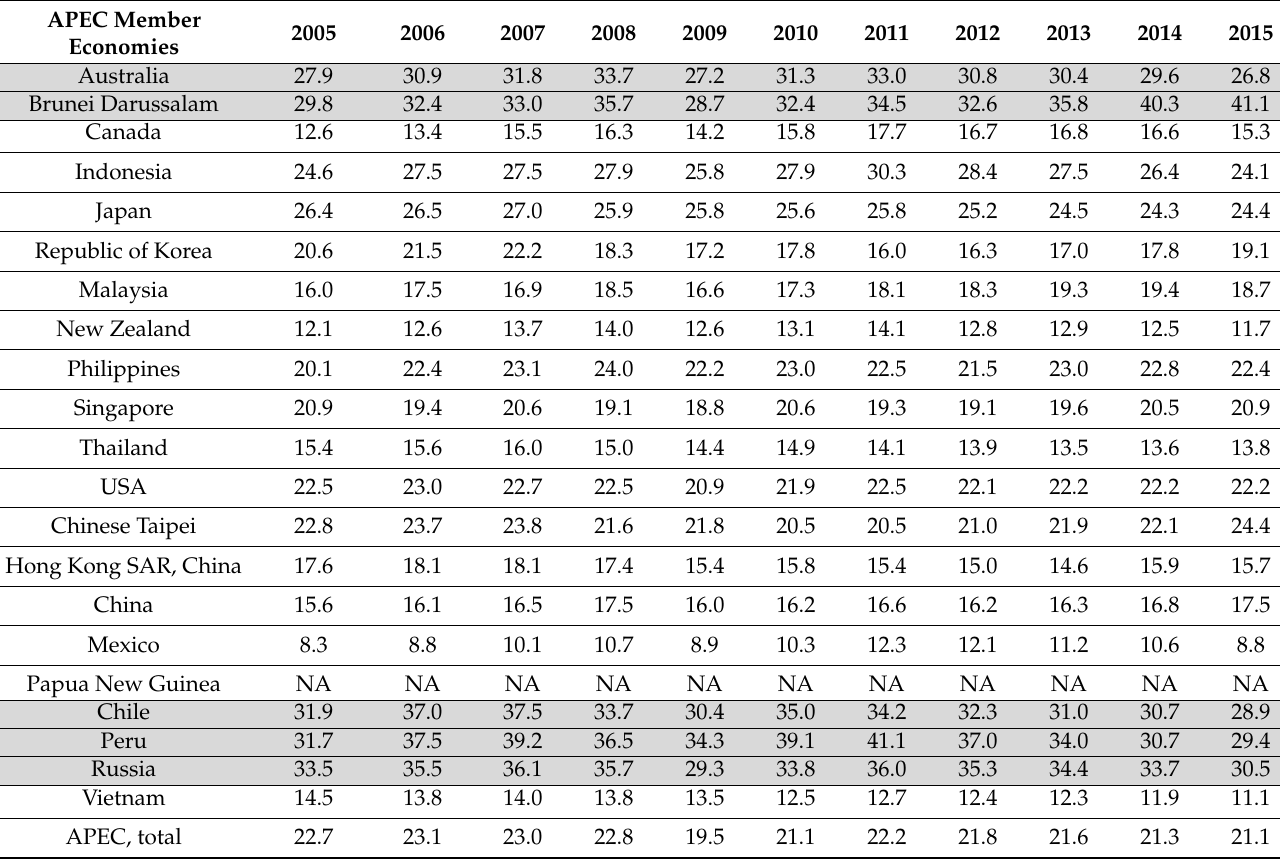
Table 5. APEC member economies’ forward GVC participation, %.